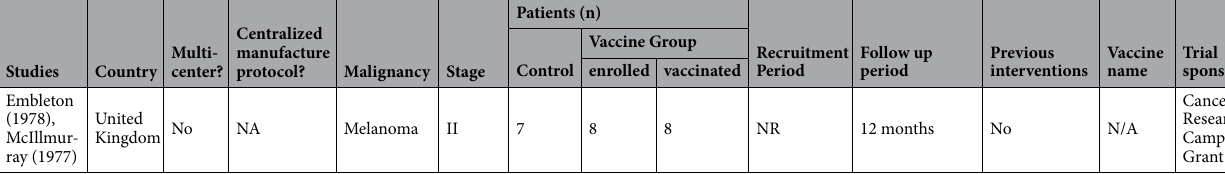
Table 1. Study characteristics. NA not applicable, NR not reported, HCC Hepatocellular Carcinoma, RCC Renal Cell Carcinoma. ° In the study by Oh (2016), 20 patients were randomized to the treatment group and 11 to the control; subsequently 10 additional patients were de-randomized and placed into treatment group. Our survival analysis focusses only on those who were randomized. † Numbers from interim analysis. *Although 205 patients were vaccinated, only 150 patients were deemed “analyzable” based on adequacy of vaccines and sufficient follow up